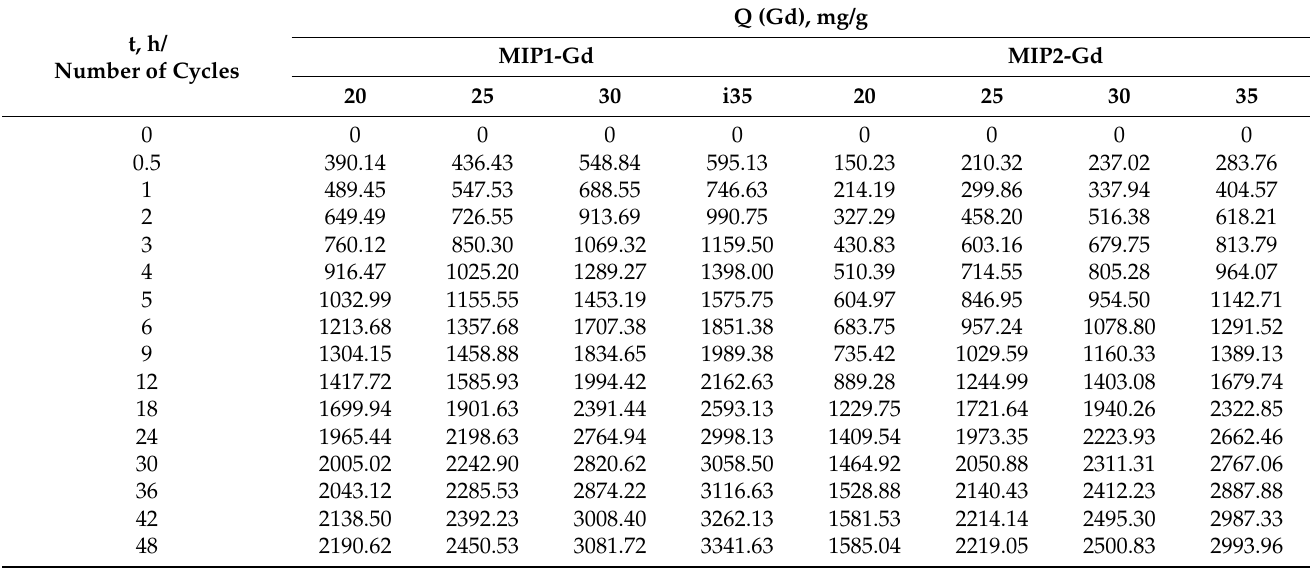
Table 7. Values of exchange capacity (in relation to gadolinium) after certain amount of template removal